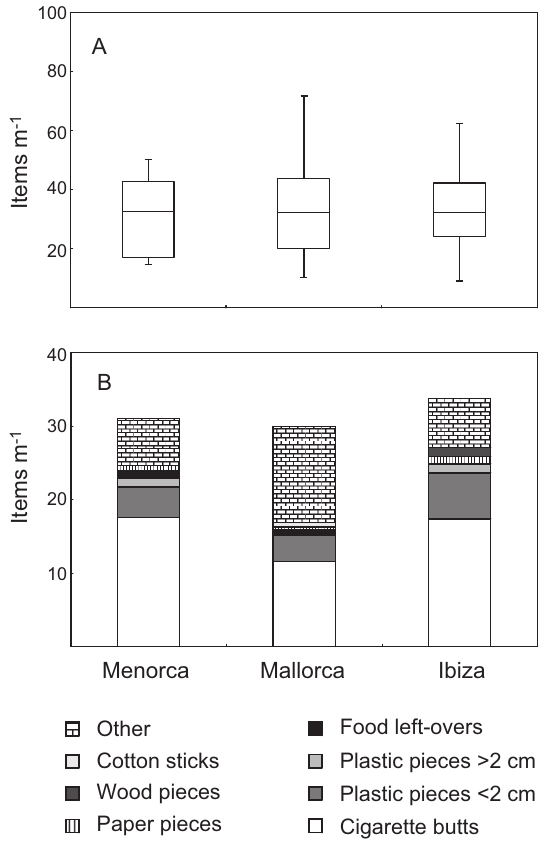
F IG . 2. – A, box plots of the average number of items per linear metre with associated standard deviations collected in Menorca, Mallorca and Ibiza in July 2005. Upper boxes represent the 75% quartile, the lower ones the 25% quartile; B, most abundant items per beach surveyed in the three Balearic islands during July